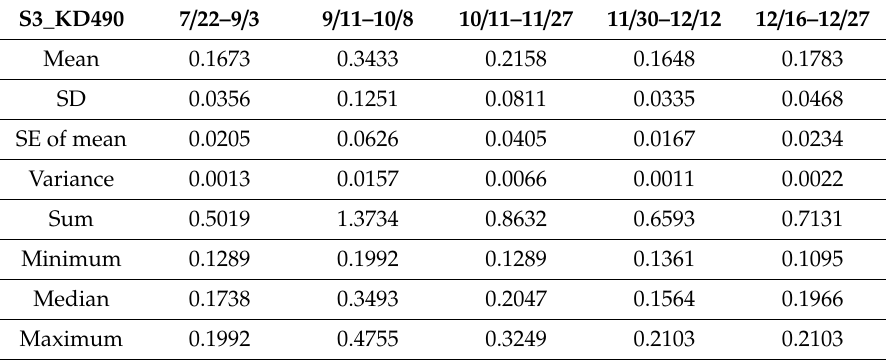
Figure 8. Box plot for light attenuation coe ffi cient (K d 490) at 490 nm field data, showing the value range, median line, mean, and the extreme values ( A ) for the year 2017 from GB to LPNR area and, ( B ) field data on station LP6 known as Turrumote II for 2017. Table 3. Statistics for five time periods on K d 490 product from Sentinel 3A.